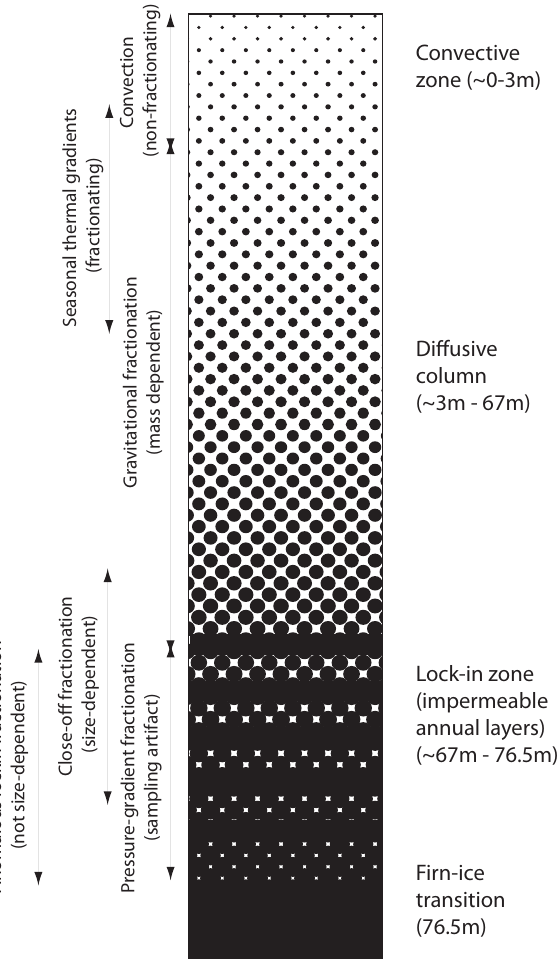
Fig. 1. A schematic diagram of regions in an idealized firn column, showing generic features (on the right) and the transport mecha- nisms expected to be significant in each region (on the left). Also shown (in parentheses on the right) are the approximate depths of the features at WAIS-D. The figure is not drawn to scale, and not all processes will be present in every naturally occurring firn